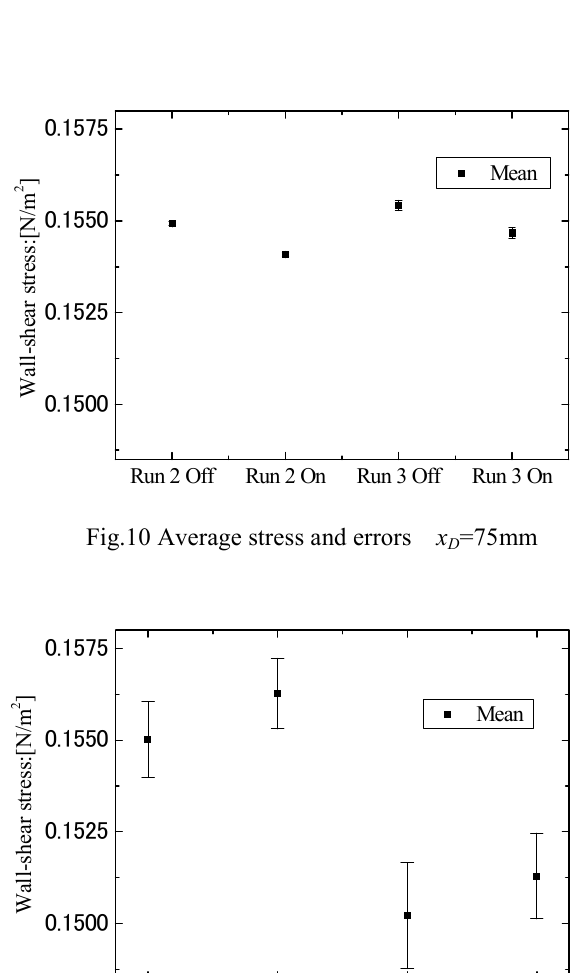
Fig.11 Average stress and